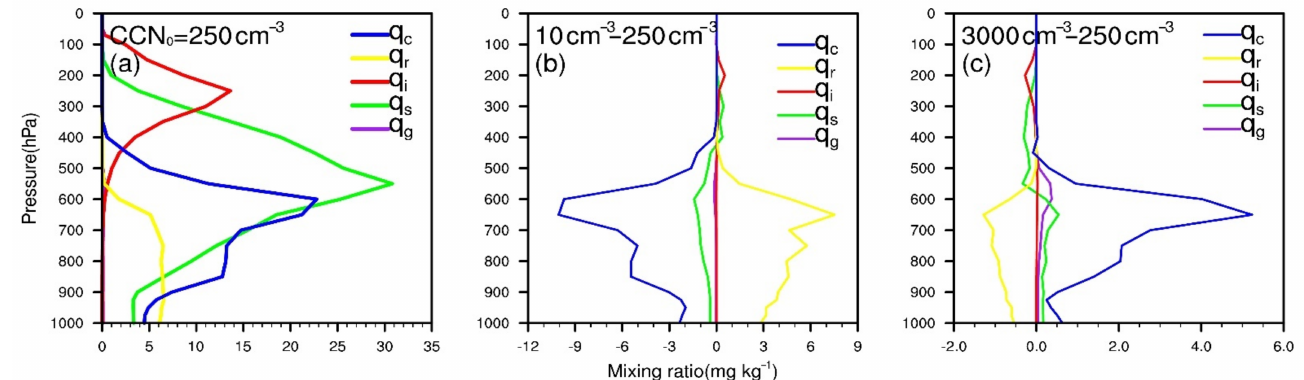
Figure 3. Vertical profiles of area-averaged q c , q r , q i , q s and q g (mg/kg) of A region from 8 to 12 October ( a ) CCN 0 = 250 cm − 3 , ( b ) the difference between CCN 0 = 10 cm − 3 and CCN 0 = 250 cm − 3 , ( c ) the difference between CCN 0 = 3000cm − 3 and CCN 0 = 250 cm − 3